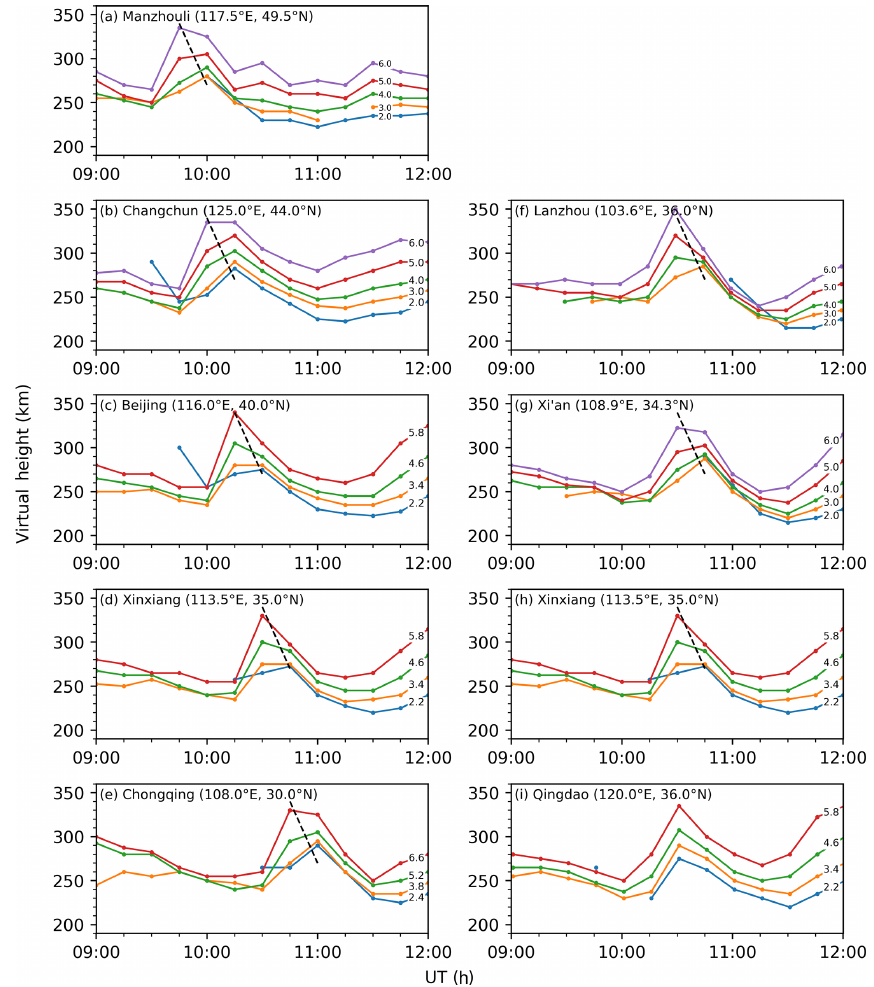
Figure 6. Temporal variations in the virtual height for iso-frequency lines from eight ionosondes between 08:00 and 12:00UT, 17 March 2015. Frequencies are depicted on each iso-frequency line. The time resolution is 15min for all stations. The black dashed lines indicate the downward phase